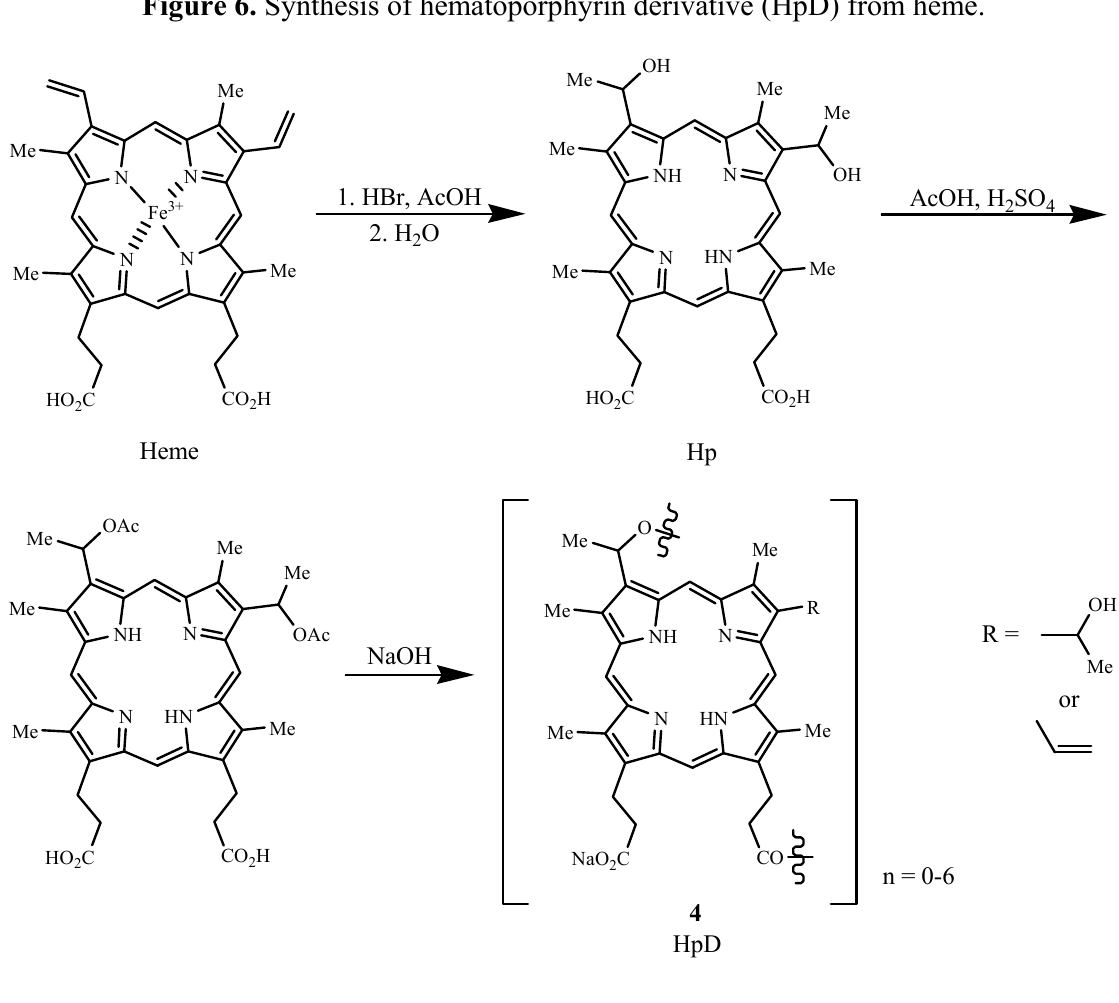
Figure 6. Synthesis of hematoporphyrin derivative (HpD) from